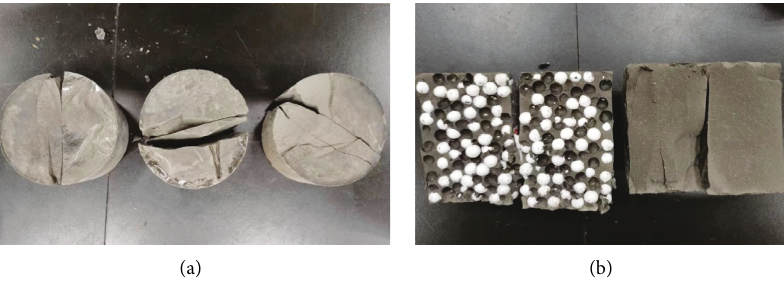
Figure 9: Fractured IDT samples. (a) Top view. (b) Side view.